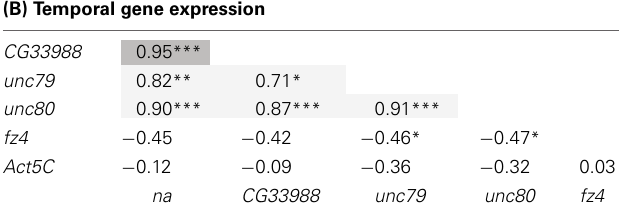
Pearson correlation tests performed on D. melanogaster gene expression data from tissue (A) and developmental series (B) experiments show that the expres- sion profiles of the na gene and its potentially associated genes are highly correlated. The expression profile of the CG33988 gene exhibits the highest cor- relation with the na gene (shaded in dark gray). All other highly correlated gene pairs (r > 0.7) are shaded in light gray. Gene names are shown at the left and bot- tom of the matrix. The gene Act5C is included as a non-related example. Pearson correlation coefficients (r) are displayed.